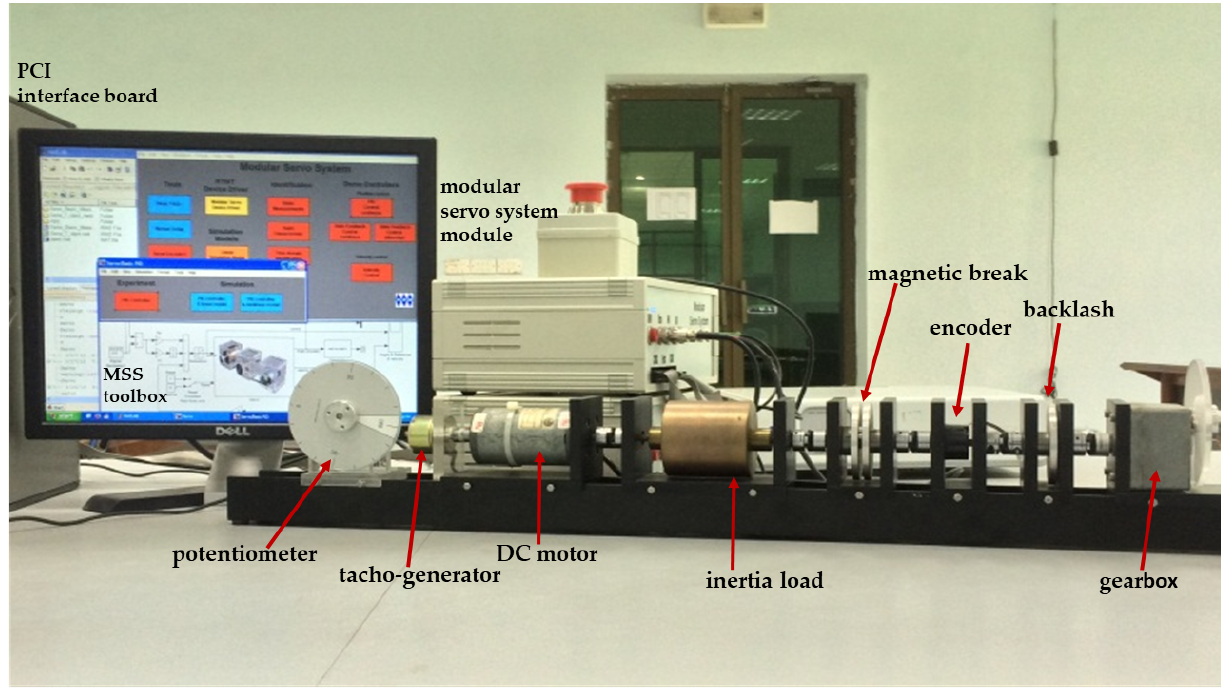
Figure 13. The experimental setup of the DC servo